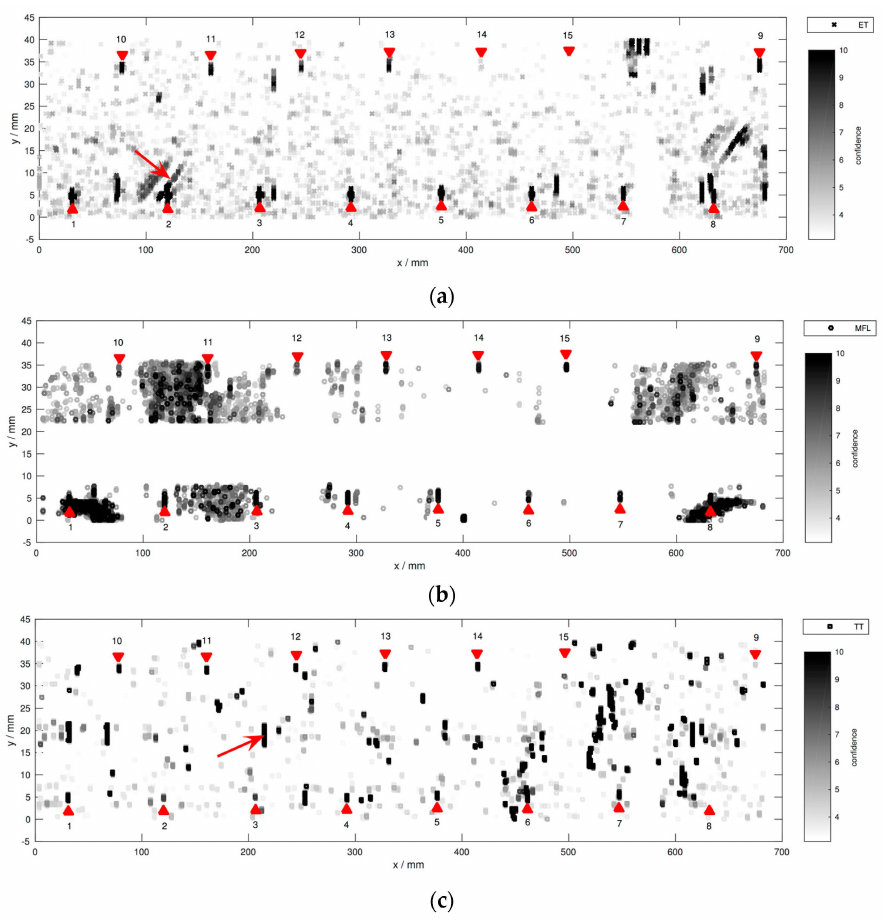
Figure 7. Hit locations per sensor in a common coordinate system similar to that in Figure 4. ( a ) ET; ( b ) MFL; ( c ) TT. Darker colors correspond to higher SNR. Note that the color scale is clipped to a maximum of 10 to prevent non-groove hits from dominating. Axes x and y are not to scale. The tips of the triangular markers indicate the groove positions. The two arrows point to prominent crack-like indications (false positives) in the ET and TT